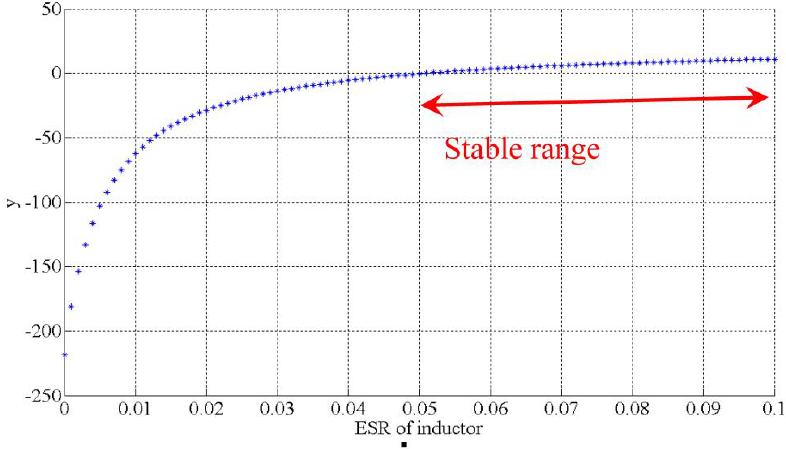
Figure 5. Stable operating range of the EMA emulator ( y is output of the closed-loop system (inductor current)).